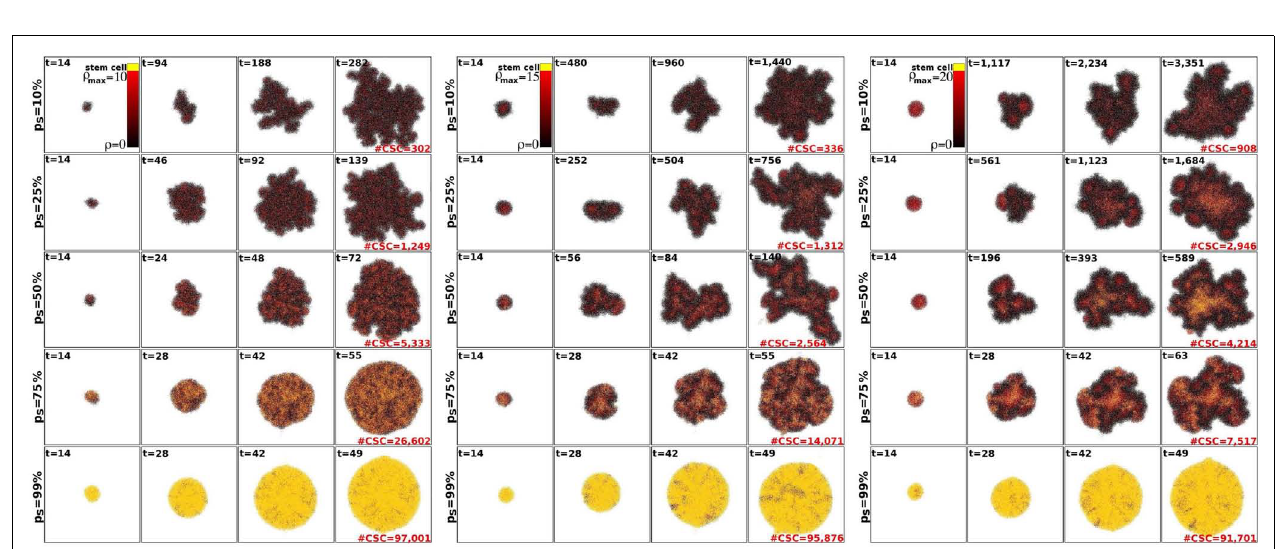
FIGURE 2 |Tumor development time and stem cell fractions depend on progeny proliferation capacity ρ max and stem cell symmetric division probability p s . The time until the tumor reaches 100,000 cells (lines) decreases with increasing p s . For small p s ( p s = 10%, 25%), the stem cell fraction (columns) increases with increasing progeny